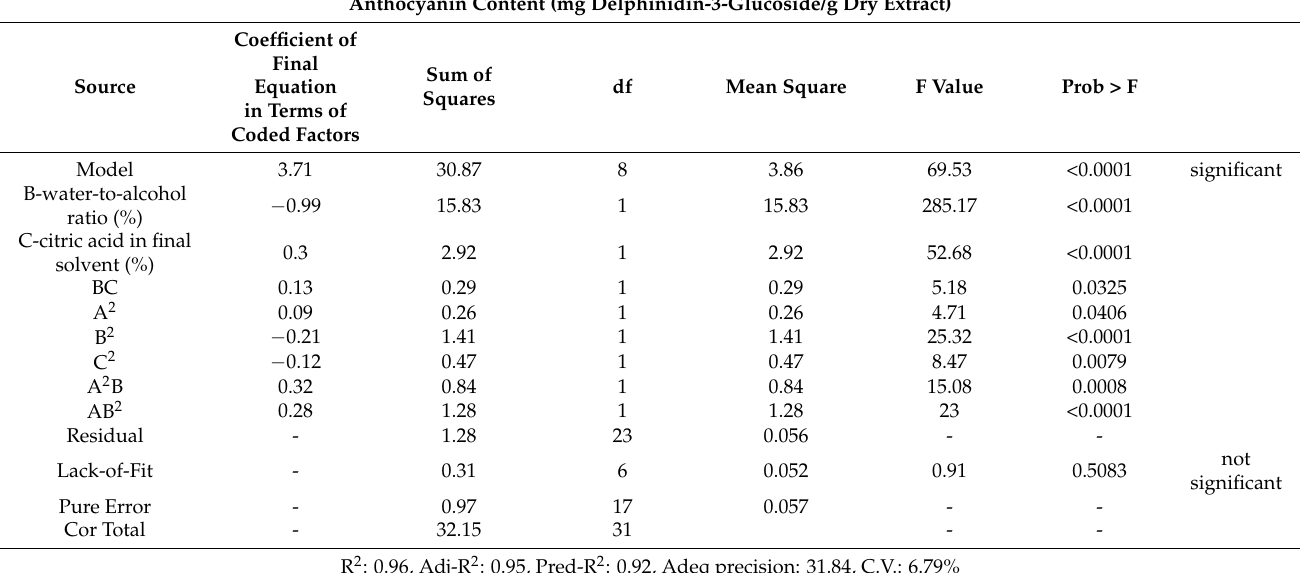
Table 3. The analysis of variance (ANOVA) of anthocyanin content (third-order fitted polynomial model) in bioactive compound extraction of eggplant peel by the different solvent